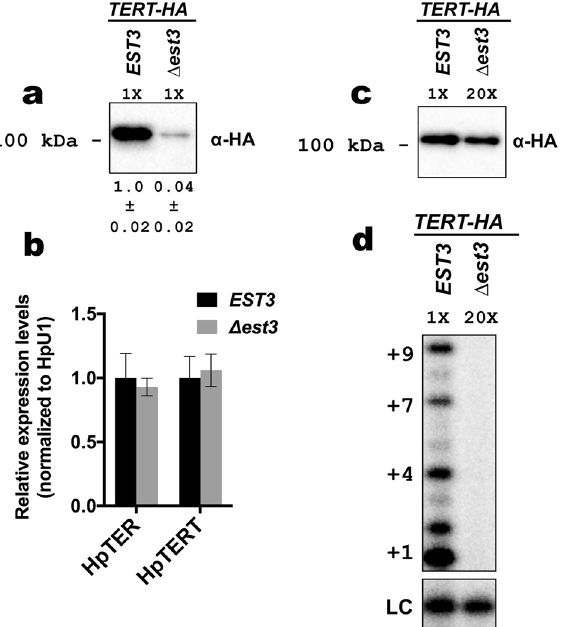
Figure 2. ( a ) Western blot analysis (with anti-HA antibodies) of TERT-HA protein levels in anti-HA precipitates prepared from the indicated strains. 1/2 portions of the IP sample obtained from 400 ml YPD cultures (OD 600 ~ 1) were used for analysis. Numbers below are quantifications of band intensities (mean ± SD); data collected from experiments with three independently grown cultures of each strain. ( b ) Expression levels of telomerase RNA (HpTER) and HpTERT mRNA in TERT-HA EST3 and TERT-HA ∆est3 strains as determined by quantitative RT-PCR. qPCR signals from test RNAs were normalized to HpU1 snRNA as described in METHODs. Data obtained using four RNA preparations are plotted in the diagram (mean ± SD). ( c ) anti-HA Western blot analysis shows comparable amount of TERT-HA protein in 1/10 portion of the IP sample obtained from 400 ml YPD culture (OD 600 ~ 1) of TERT-HA EST3 and in 1/2 portion of the IP sample obtained from 1,600 ml YPD culture (OD (containing similar amount of TERT) with HD5 primer. Telomerase elongation products (up to + 9 nucleotides) are visible in TERT-HA EST3 sample, but not in TERT-HA ∆est3 . “LC” loading control (a [γ- 32 P]-labeled 13-mer oligomer). Data in ( c and d ) are representative of three independent experiments. Original (full lane view, no contrast adjustment) blots and gels from ( a , c and d ) are shown in Supplementary Figs. S14 and